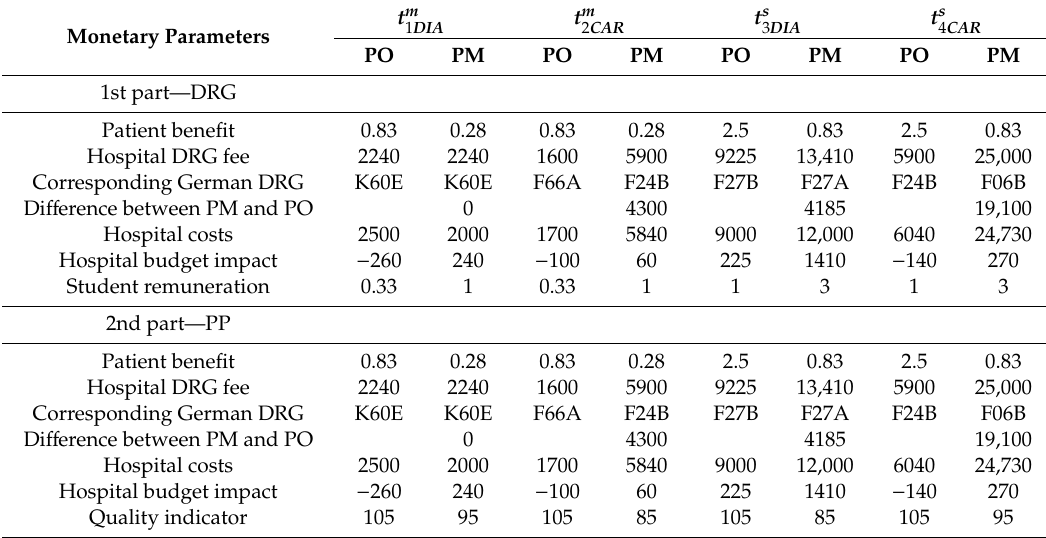
Table A5. Monetary Parameters for Medical Students w Patient Benefit—Treatment Cases 1–4. Monetary